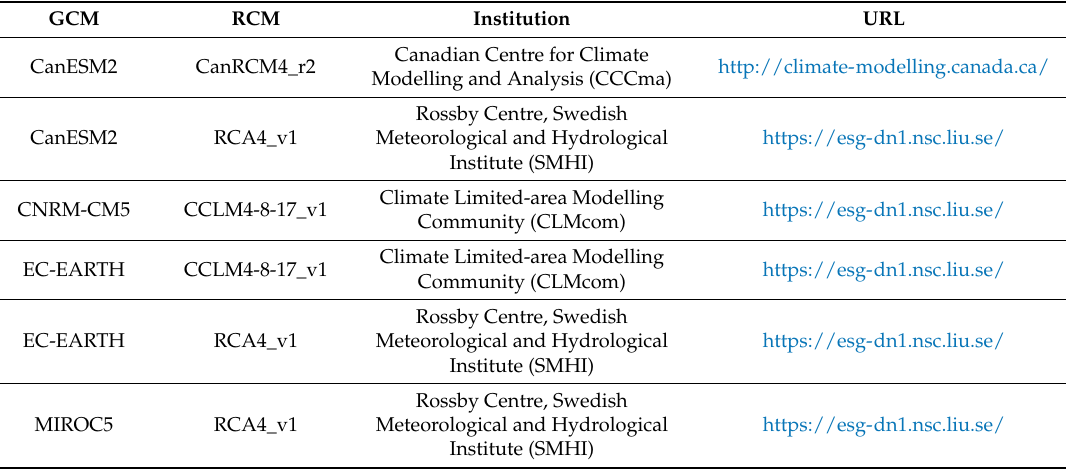
Table 2. Overview of the applied Regional Climate Models (RCMs) and their driving Global Climate Models